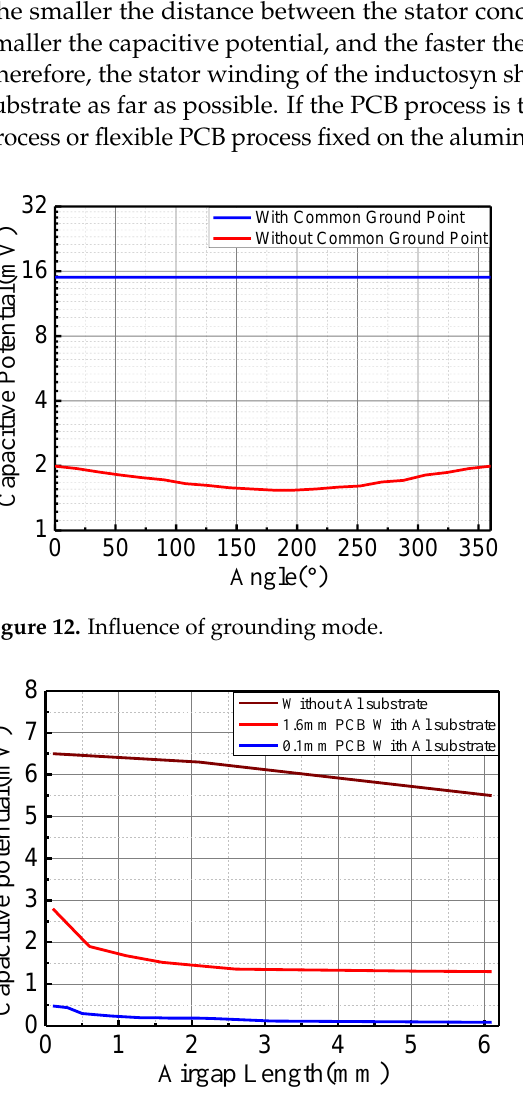
Figure 13. Influence of substrate.